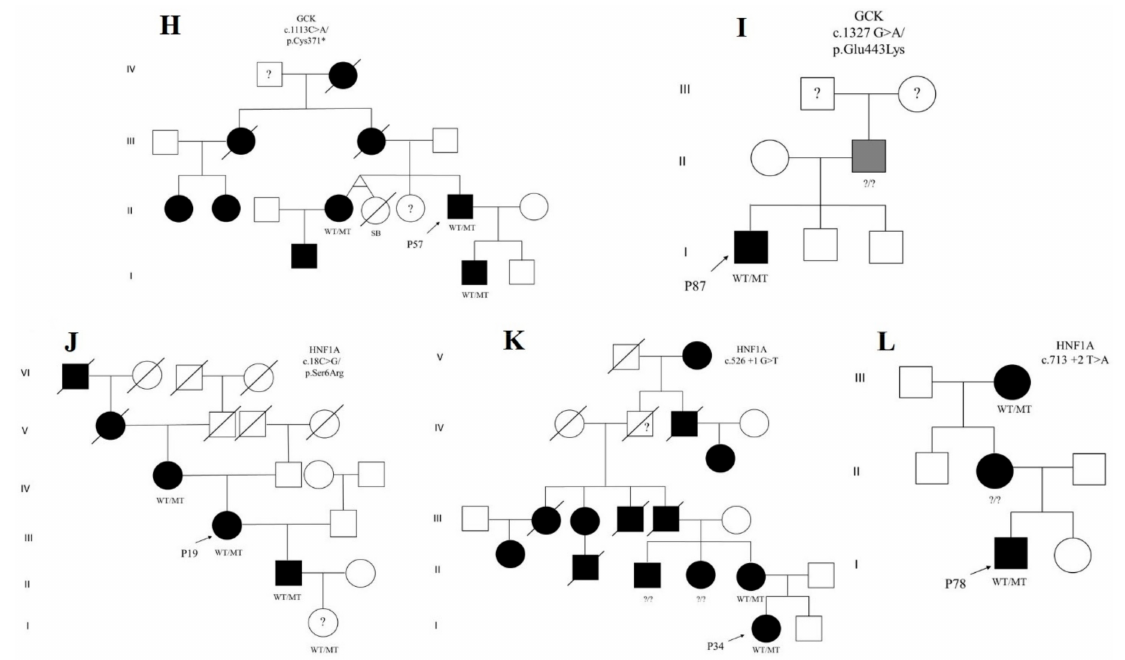
Figure 2. Screened MODY families ( A – L ) with novel identified variants in genes GCK and HNF1A . A grey filled symbol: a patient with prediabetes, MT: altered allele, SB: stillbirth, WT: wild type allele, ?/?: persons not genotyped, ?: a person with unknown health status. * RefSeq reference transcript: GCK (NM_000162.5), ABCC8 (NM_000352.3), HNF1B (NM_000458.2), and HNF1A